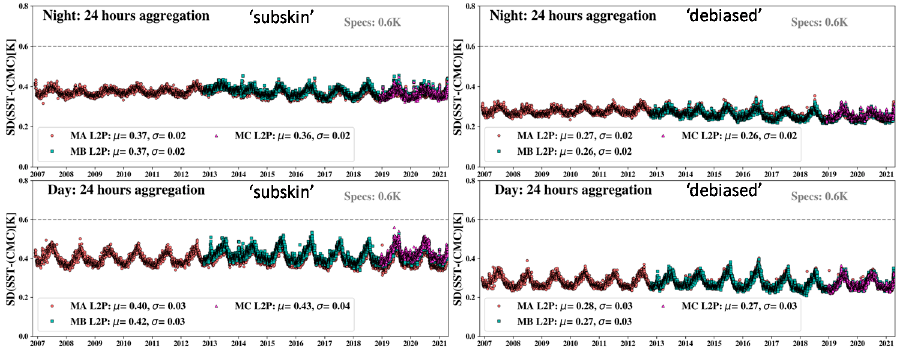
Figure 17. Same as in Figure 15 but for the corresponding global standard deviations (SDs).